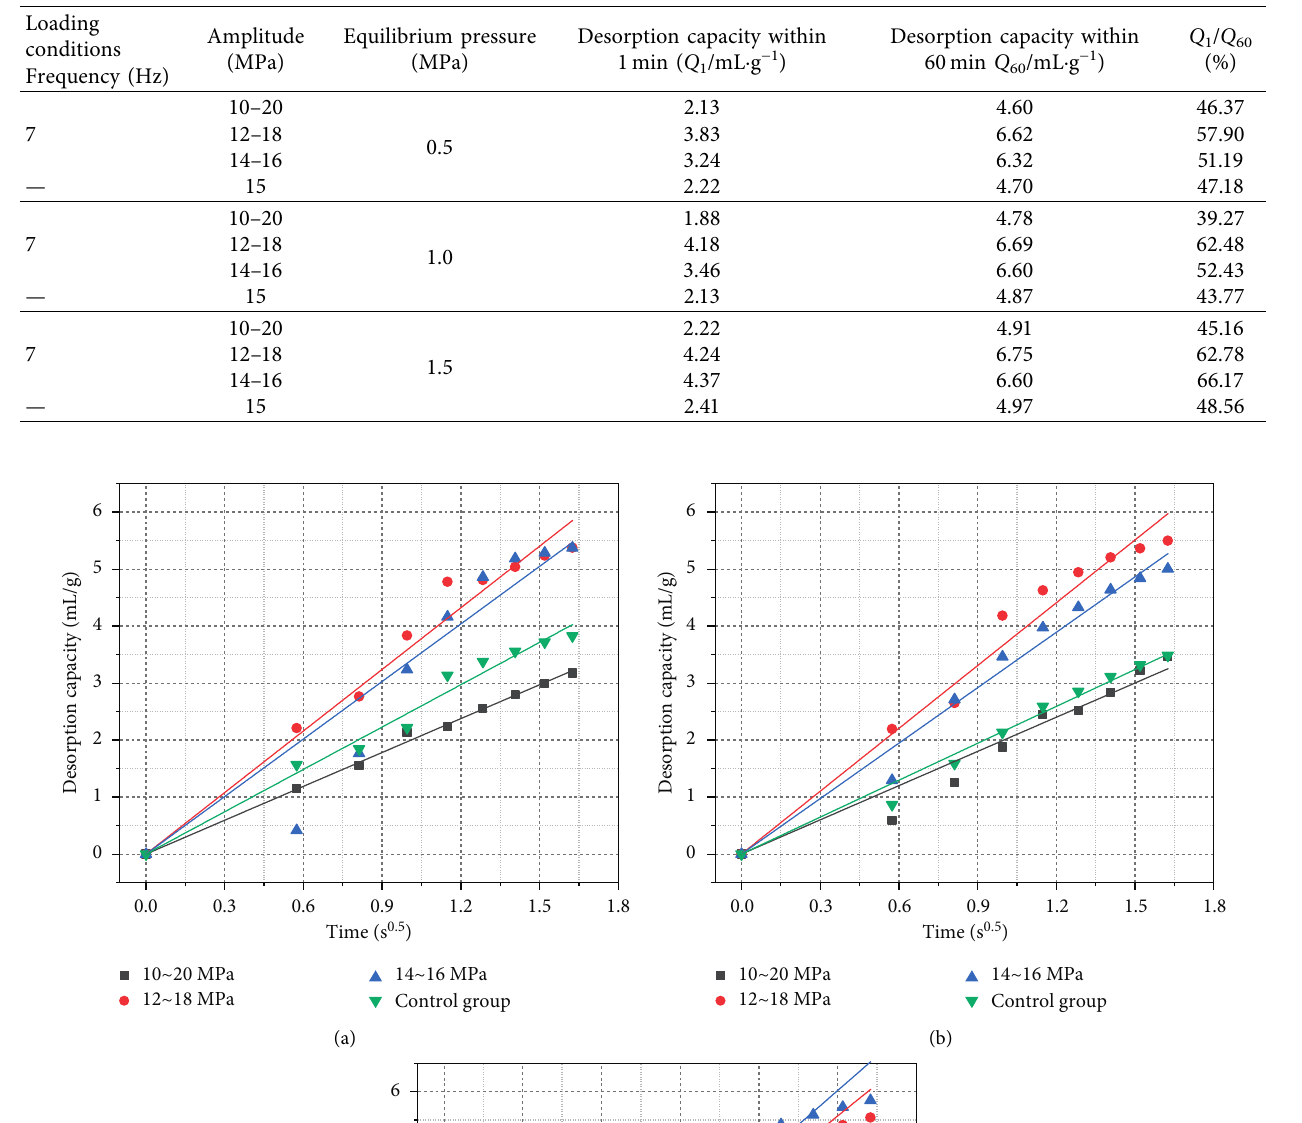
Table 5: Cumulative desorption capacities of briquettes under different loading amplitudes.